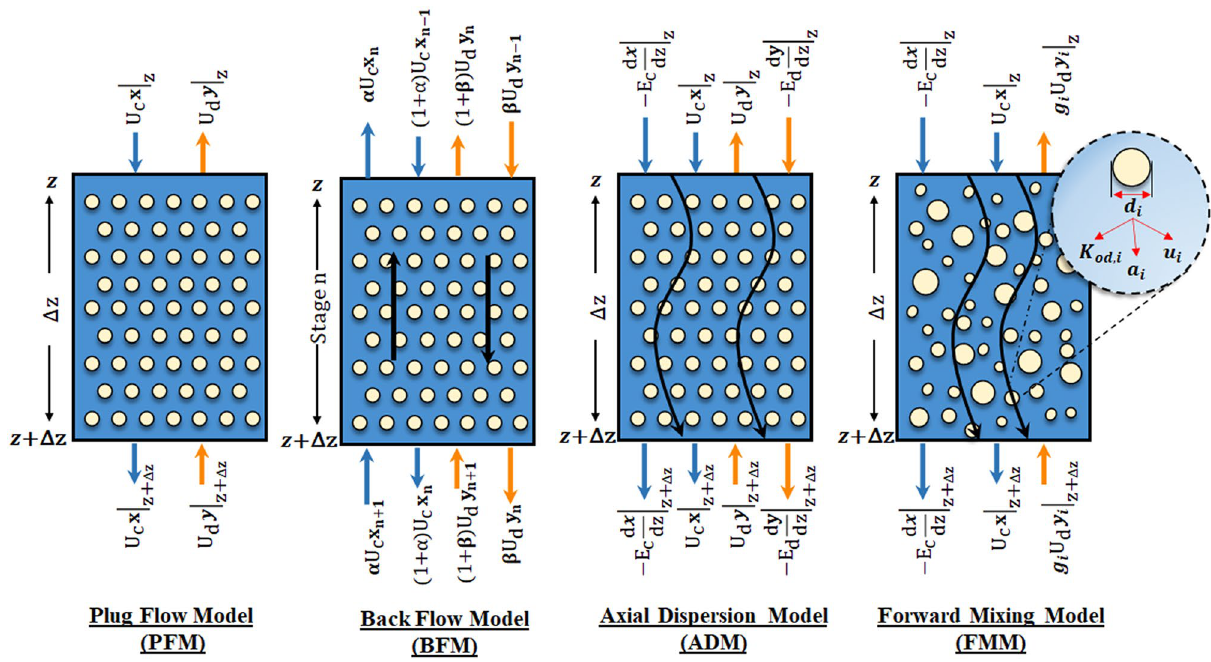
Figure 1. Mass balance over a volumetric element based on the plug flow, back-flow, axial dispersion and forward mixing models.